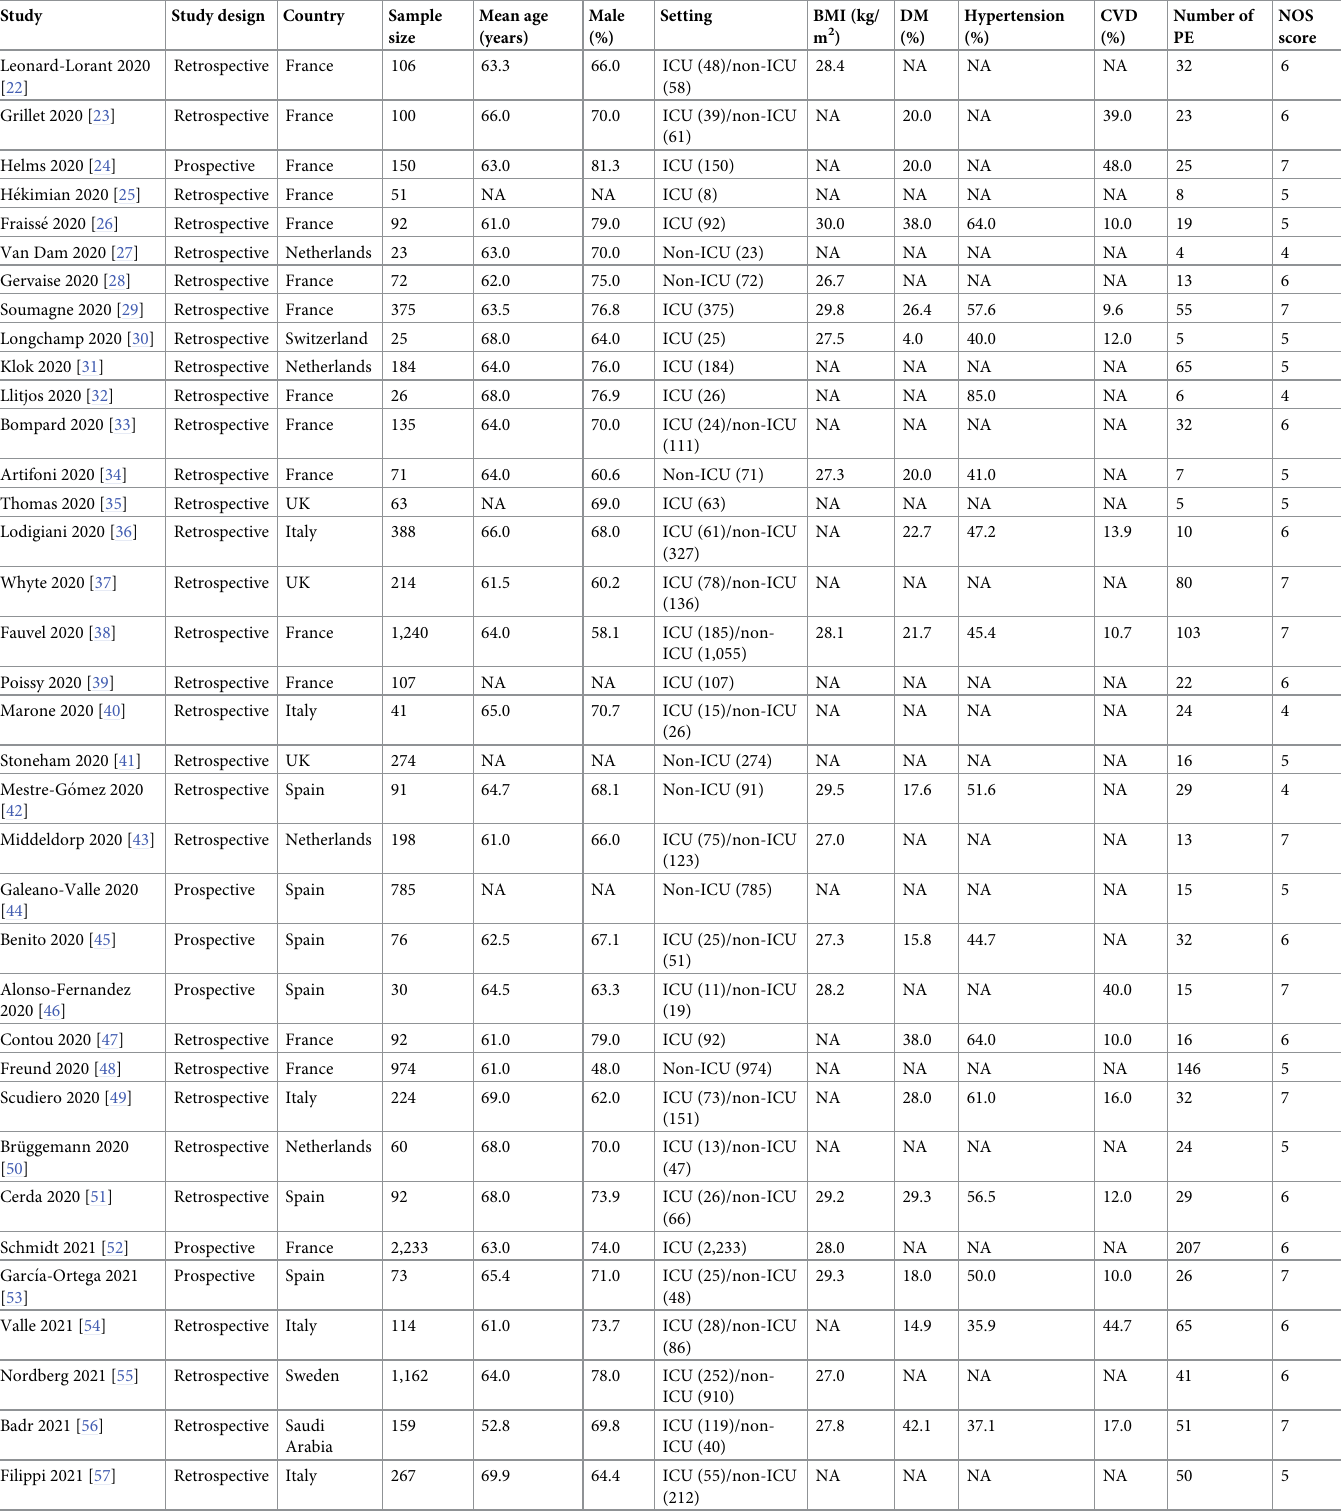
Table 1. The baseline characteristics of included studies and